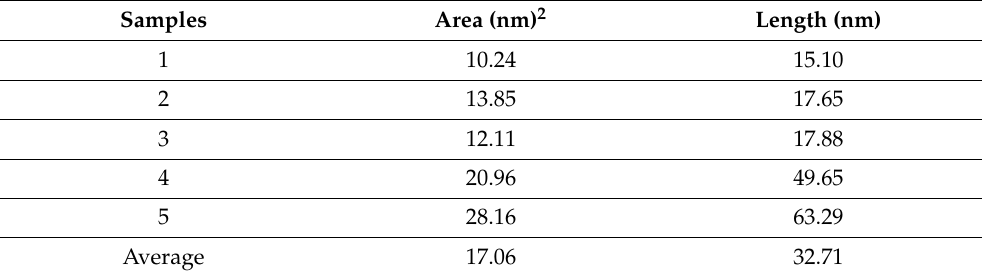
Table 1. CCsMFO particle size.